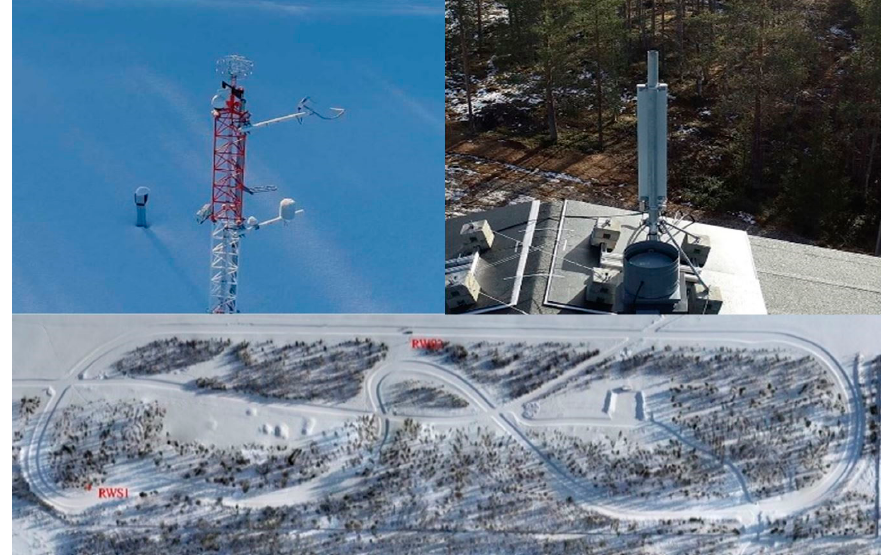
Figure 3. Test-track equipped with the 5G Test Network (5GTN) base station and Road Weather Stations (RWSs).